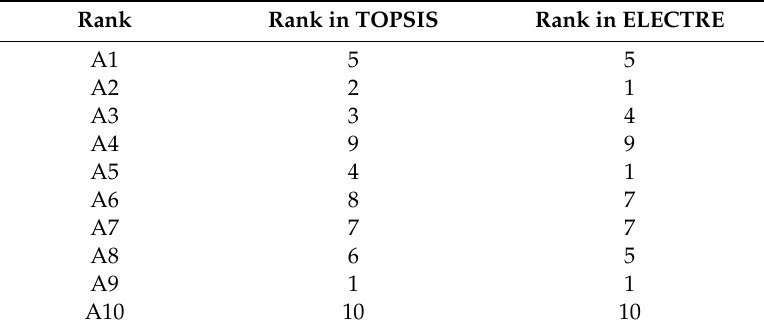
Table 28. Comparing TOPSIS and ELECTRE I method results.